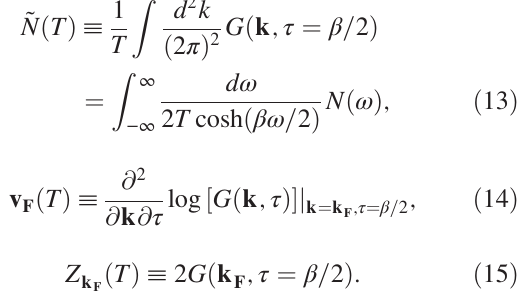
as a function of s;d